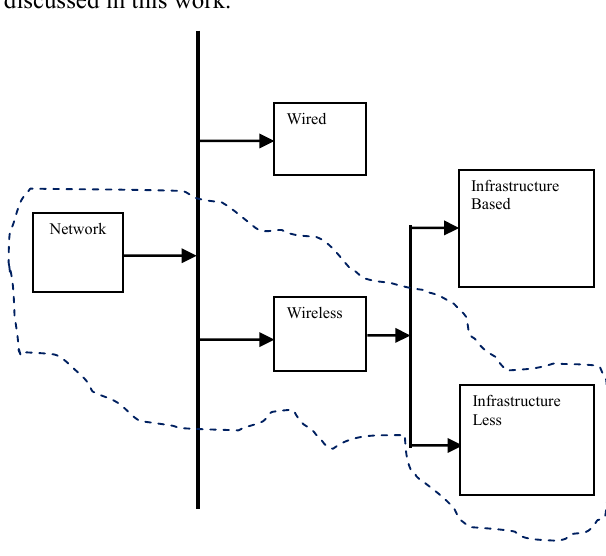
Figure 1. Category of networks